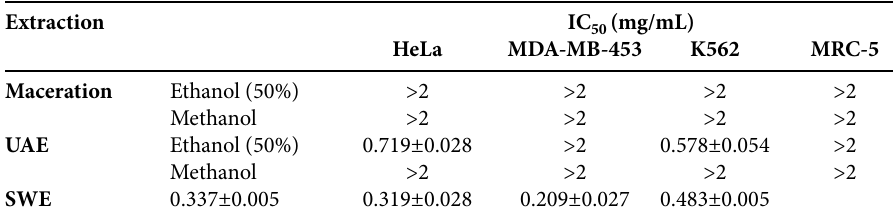
Table 7. Antiproliferative activity of comfrey root extracts